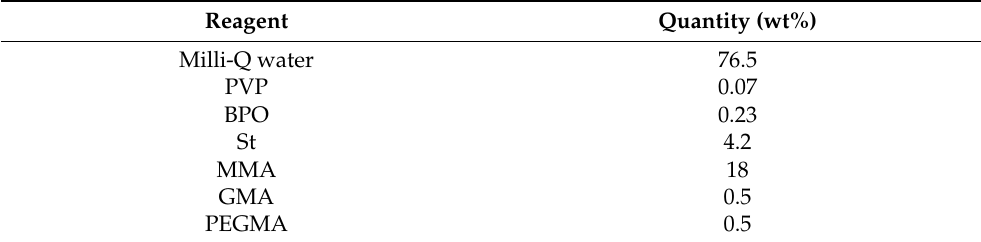
Table 1. Reaction recipe for the synthesis of the St-MMA-GMA-PEGMA particles. Reagent Quantity